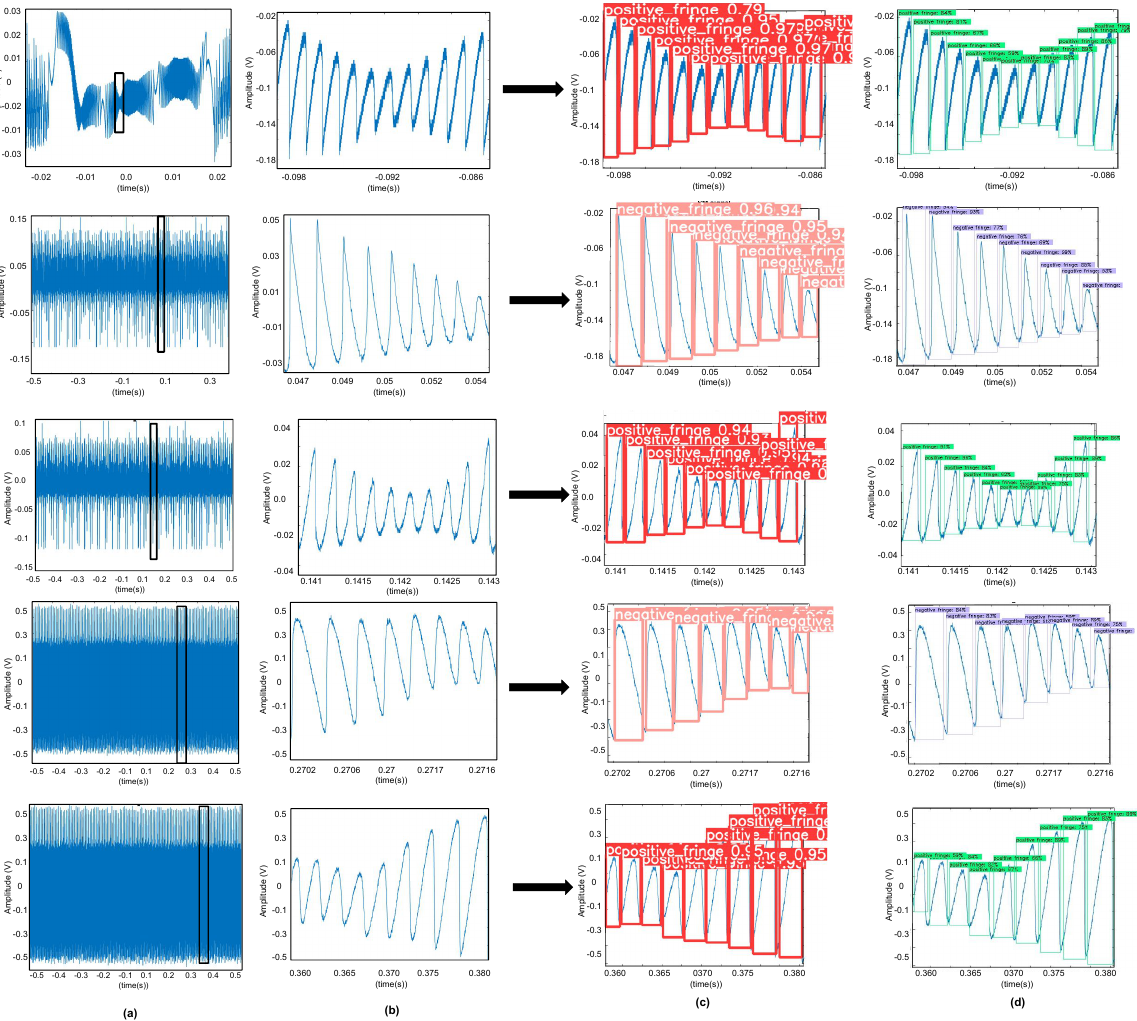
Figure 14. Results of testing of trained DNNs on speckle affected experimental SMI signals: ( a ) SMI signals, ( b ) enlarged view of a segment of the SMI signal, and ( c , d ) show the results provided by YOLOv5 and EfficientDet,